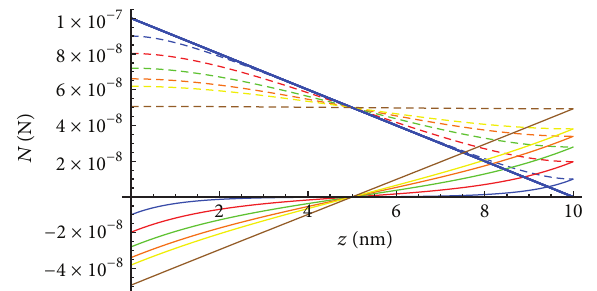
Figure 4: Axial force 𝑁 = 𝑁 𝑜 − 𝑁 (1) 1 (blue line), 𝑁 𝑜 (dashed line), 𝑁 (1) 𝑐 = 0 (local solution-black line), 𝑐 = 1 (continuous thin line); 1 nm (blue line), 𝑐 = 2 nm (red line), 𝑐 = 3 nm (green line), 𝑐 = 4 nm (orange line), 𝑐 = 5 nm (yellow line), and 𝑐 = 25 nm (brown